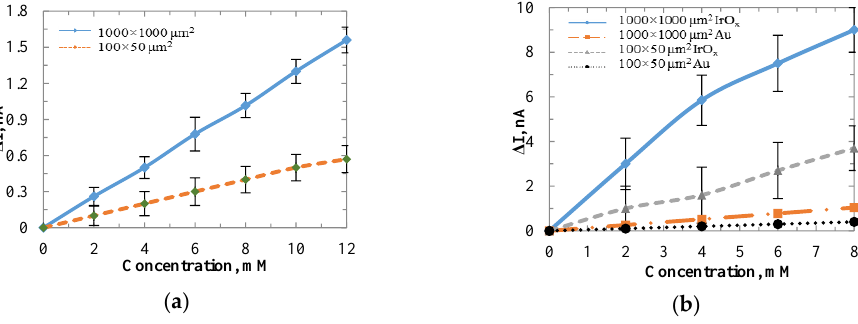
Figure 7. Sensitivity comparison for ( a ) Au electrodes with sensing areas of 1000 × 1000 μm and 100 × 50 μm; and ( b ) Au and IrO x electrodes with areas of 500 × 500 μm and 1000 × 1000 μm.